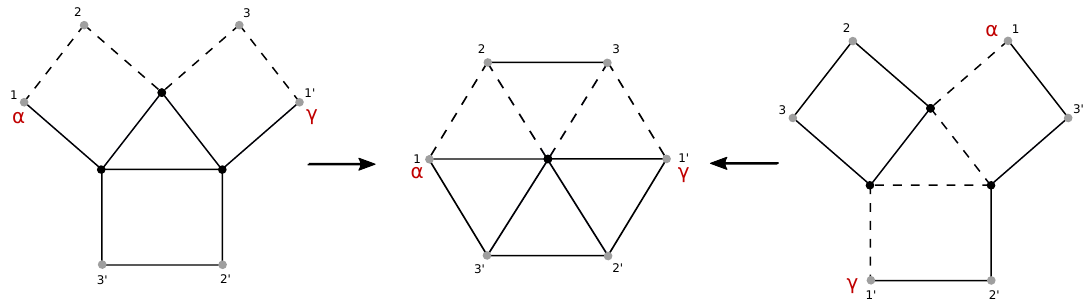
Figure 8 . Graphical representation of relation (2.28) of Yang-Baxter type. The squares represent the kernels of R ( v (cid:0) u ) 23 (solid lines) and ( ~ R 12 ) (cid:11) ( u ), ( ~ R 13 ) (cid:12) ( v ) (solid and dashed lines). Black (cid:13) (cid:12) dots are integration points, while gray blobs are external coordinates. Figures on the left and on the right are respectively the L.H.S. and R.H.S. of (2.28). Both sides can be transformed in the hexagonal object in the middle. First the triangle is opened into a star integral using (C.1) (left side) or (C.2) (right side). Doing so, each of the three black dots will become the end of only three lines. Then integration can be performed by (C.1), (C.2) and leads to the